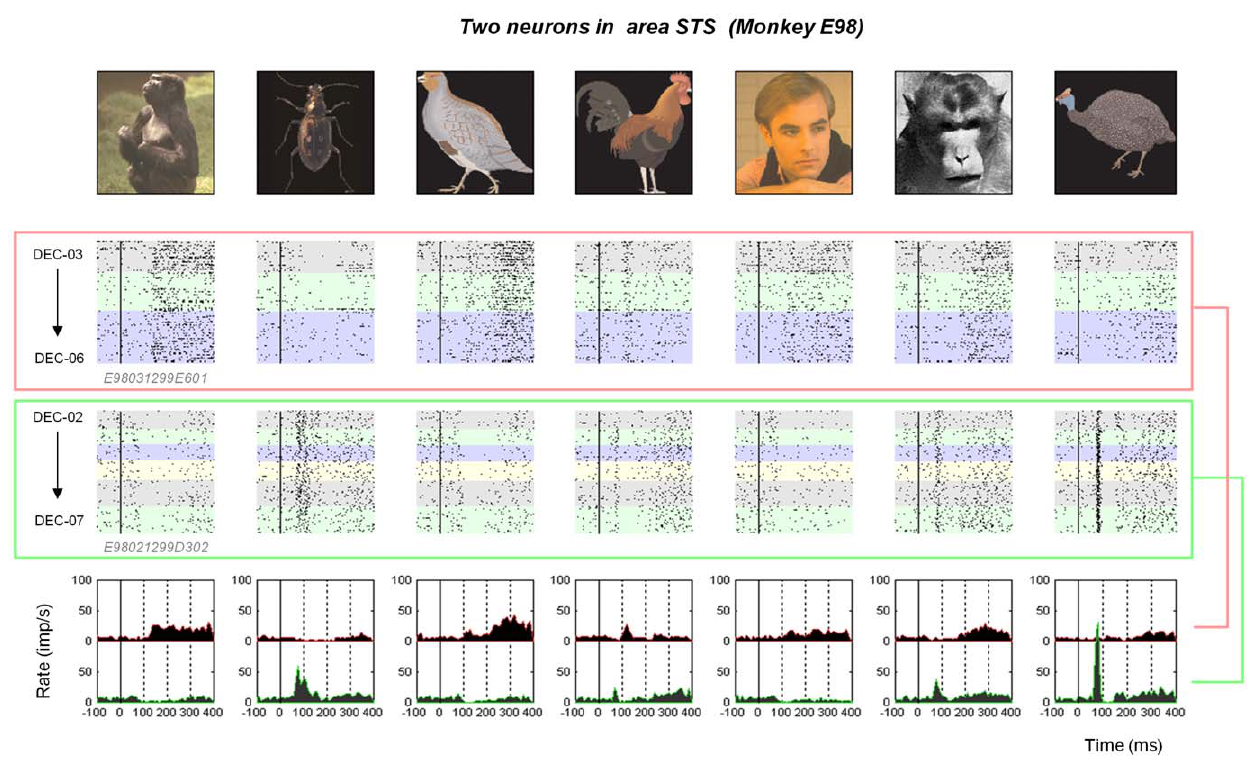
Figure 2. Single unit responses in the STS. Data are shown from two neurons collected on two different microelectrodes from monkey E98 in the same format as Figure 1 . The data were collected simultaneously for three days, after which the lower neuron was monitored for an additional 3 days.